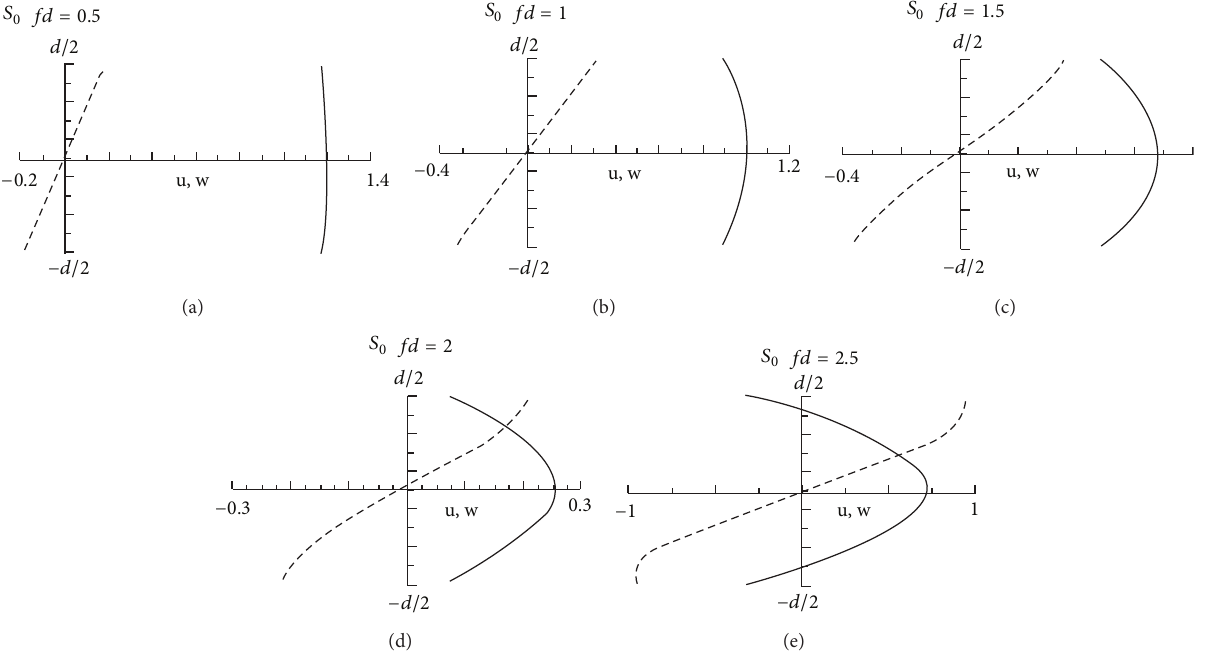
Figure 2: A wave structure for various points (particle displacements) for the 𝑆 0 mode in an aluminum plate, showing the in-plane (u— solid line) and out-of-plane (w—dashed line) displacement profiles across the thickness of the plate, for different wave frequency and plate thickness products [1,